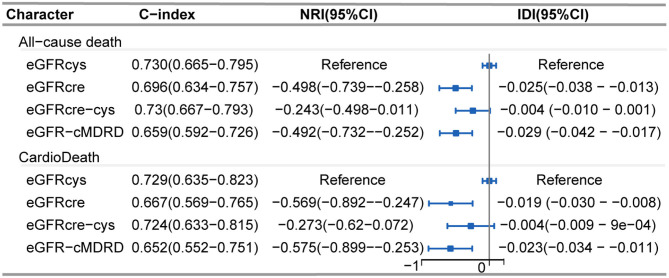
Forest plot showing net reclassification improvement of renal function calculated by various eGFR equations. Net reclassification improvement in all-cause mortality and cardiac death was assessed by comparing eGFRcre, eGFRcre-cys, and eGFR-cMRDR with eGFRcys (reference), individually. C-index: Harrell's concordance index. NRI, Net reclassification improvement; IDI, integrated discrimination improvement; CI, confidence interval.